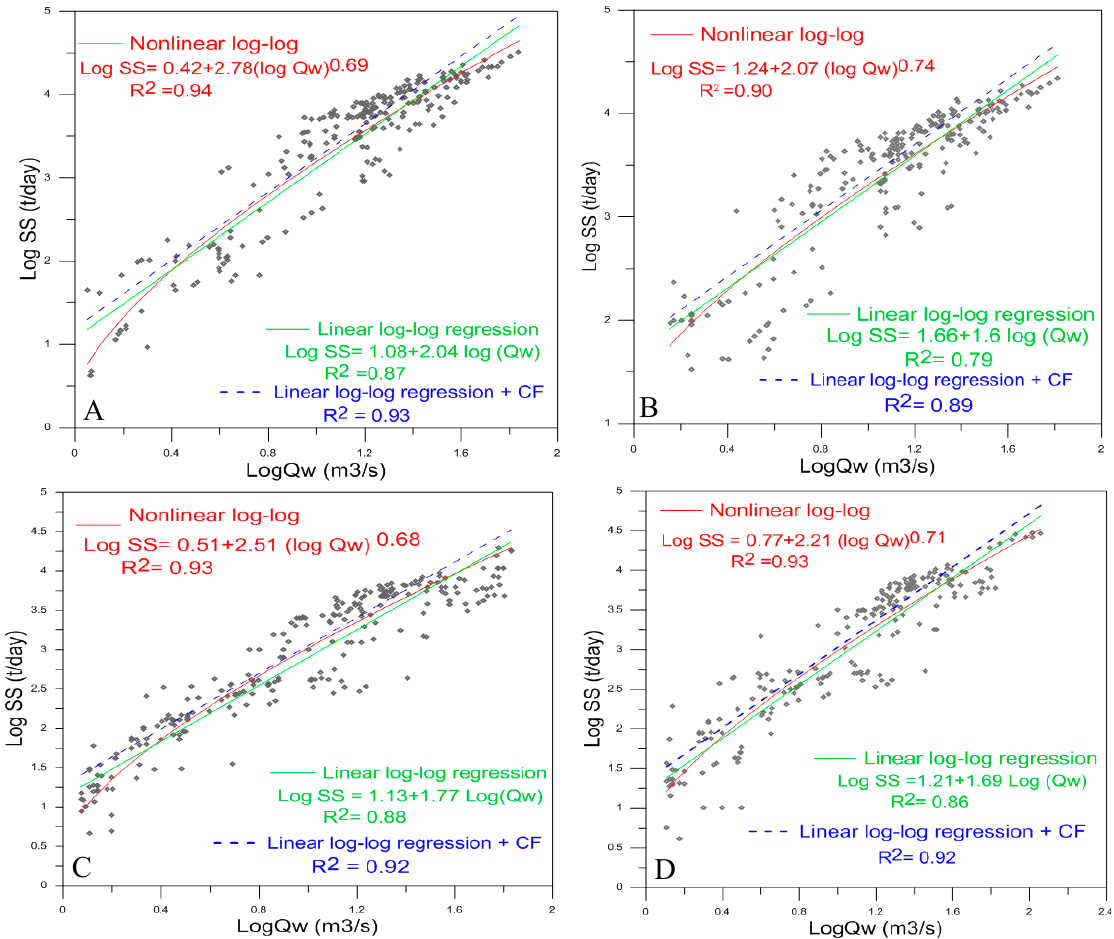
Figure 6. The developed rating curves ( A ) at station Duguda; ( B ) Maki; ( C ) Abura; and ( D ) Fite. The comparison plots between measured and computed data with three di ff erent rating curves, namely rating curve developed by normal linear log–log regression (Equation (1)), normal linear log–log regression with correction factor (Equation (2)), and non-linear least squares regression (Equation (4)) is shown in figure (Figure